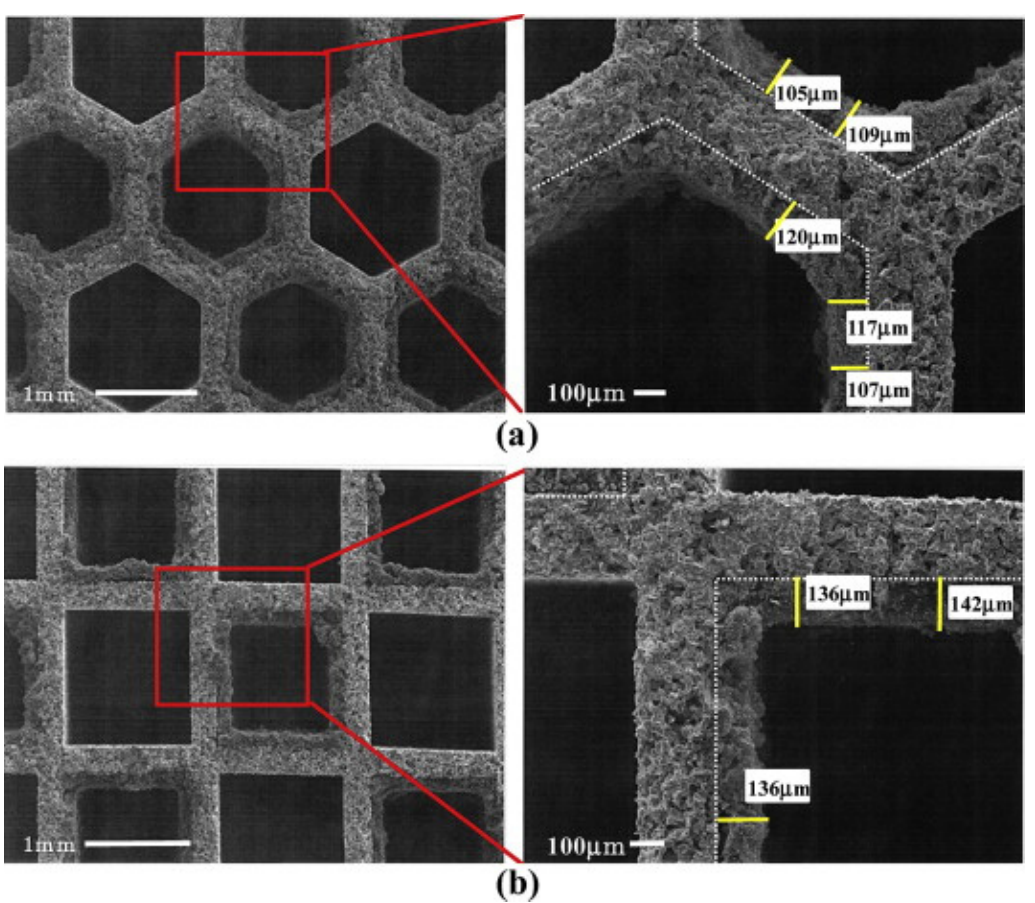
Figure 7. SEM images of the soot cake regions for ( a ) hexagonal- and ( b ) square-cell DPFs. From [45]. In addition, under controlled regeneration conditions (i.e., constant oxygen concentration and temperature of the inlet gas), enhanced soot oxidation and higher regeneration e ffi ciency were found for the catalytic DPF with hexagonal